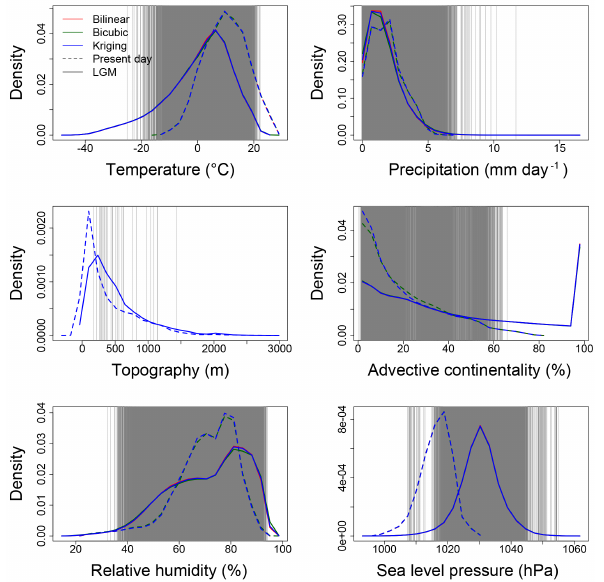
Figure 4. Splines of the GAM for precipitation. The splines are scaled to the same range to allow for visual estimation of their rel- ative importance. The range of the x axes combines the ranges of values for the present-day period and the LGM. The grey lines indi- cate the values for the 12 months over the 50 years during the LGM at the archaeological sites of Fig. 1 (except for the elevation, for which there is only one value per